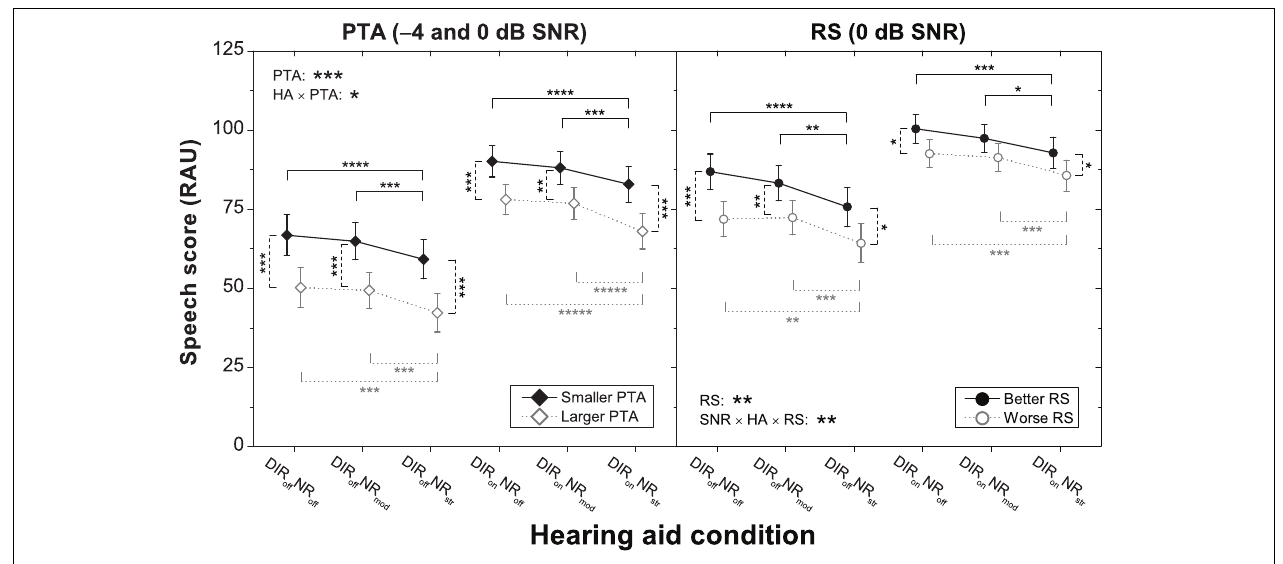
FIGURE 3 | Mean speech scores for the six HA conditions for the “smaller PTA” and “larger PTA” subgroups at − 4 and 0dB SNR (left panel) and the “better RS” and “worse RS” subgroups at 0dB SNR (right panel). Error bars show 95% confidence intervals. Black solid horizontal bars denote significant differences for the “smaller PTA” and